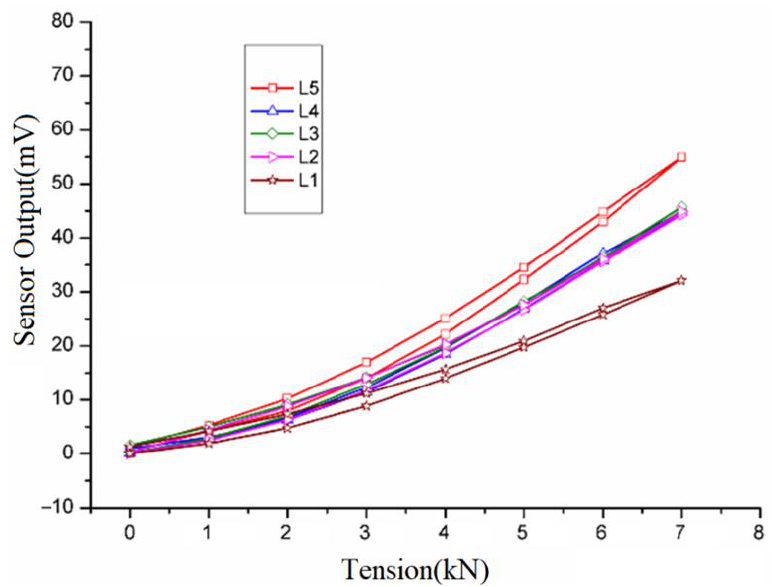
Figure 13. Sense signal curve with gaps variation of the inductive sensor.